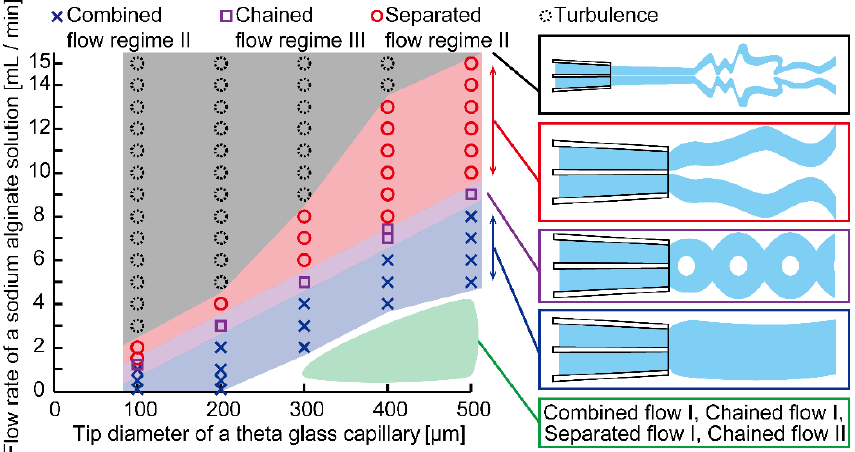
Figure 5. Experimental phases showing relationships between the flow regimes, flow rate of the sodium alginate solution, and tip diameter of the theta-glass capillary. Refer to Figure S1 for detailed data of the bottom-right regime.